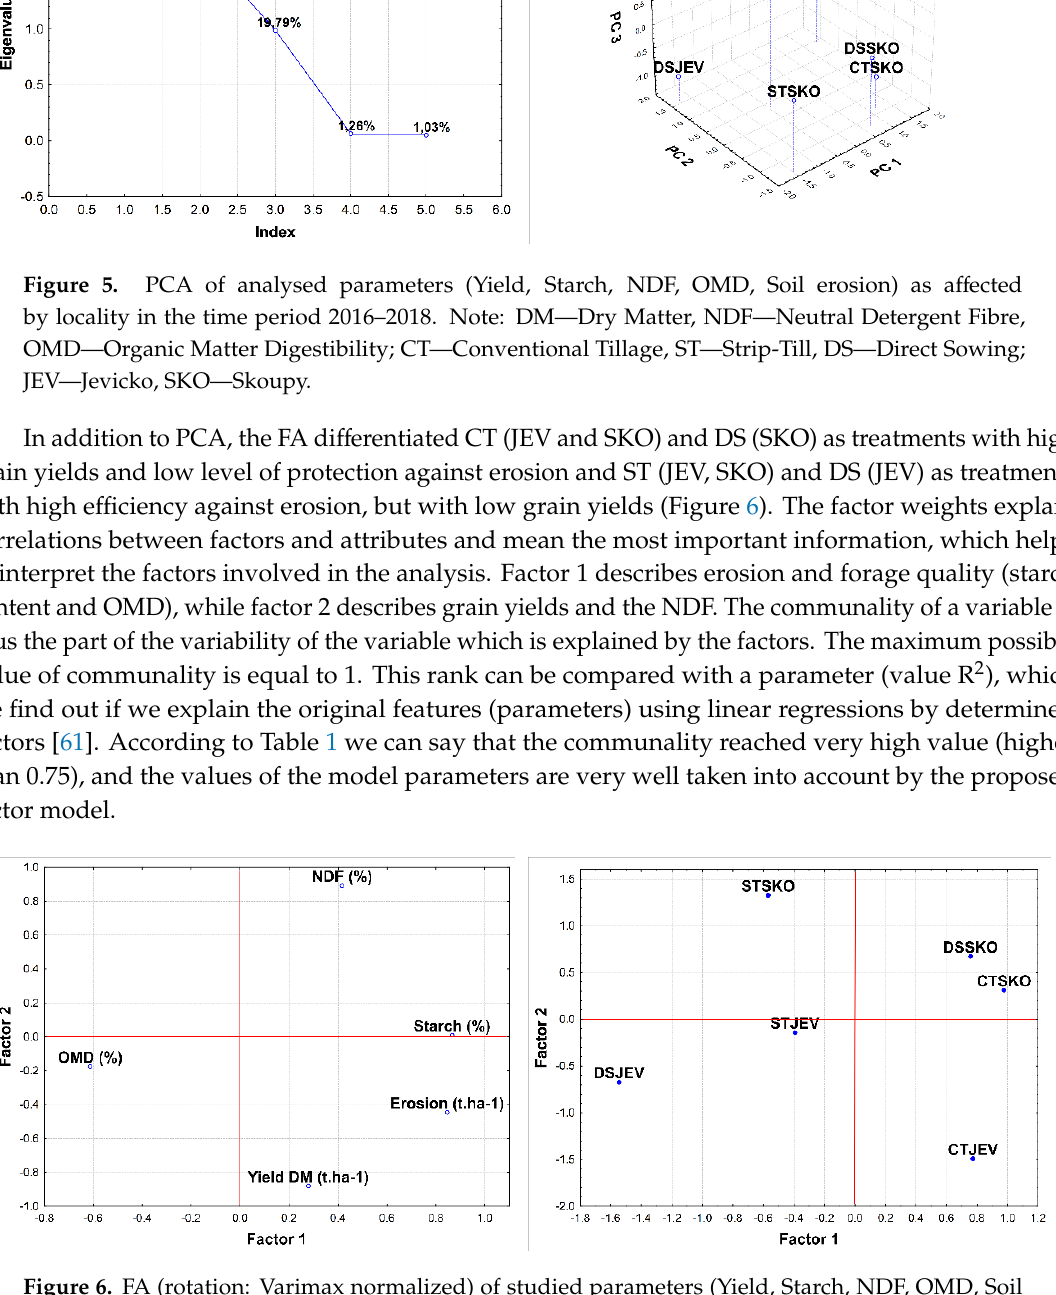
Figure 6. FA (rotation: Varimax normalized) of studied parameters (Yield, Starch, NDF, OMD, Soil erosion) as affected by locality in the time period 2016–2018. Note: DM—Dry Matter, NDF—Neutral Detergent Fibre, OMD—Organic Matter Digestibility; CT—Conventional Tillage, ST—Strip-Till, DS—Direct Sowing; JEV—Jevicko, SKO—Skoupy.